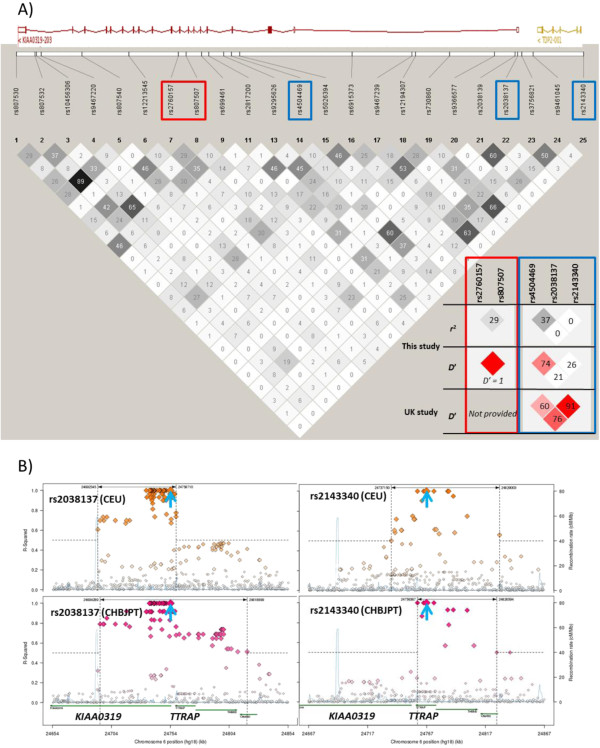
Linkage disequilibrium plots of SNPs located in KIAA0319.(A) Inter-SNP linkage disequilibrium was generated for studied markers covering KIAA0319 using Haploview 4.0 [13]. Color scheme represents the r2 value (stronger linkage disequilibrium is shown using progressively darker shading). Schematic diagram of KIAA0319 and TDP2 genes obtained from Ensembl (http://www.ensembl.org). Right bottom: Linkage disequilibrium plots of the significant haplotype rs2760157-rs807507 (Red box) found in this study (Hong Kong sample) and the haplotype rs4504469-2038137-2143340 (Blue box) studied in Paracchini et al. (UK sample) [16]. Linkage disequilibrium plot represent D’ measure was also generated. The cells are color in red gradually representing strength of LD between the two markers: Bright red (LOD ≥ 2 D’ = 1), pink red (LOD ≥ 2 D’ < 1) and white color for no or weak LD (LOD < 2, D’ < 1). (B) Regional LD plots in KIAA0319 5′ and TTRAP (TDP2) genomic region (plots were generated using SNAP web-based software at the Broad Institute [17] and data from 1000 Genomes Project Pilot 1). r2 value relative to rs2038137 and rs2143340 (indicated by blue arrows) in CEU and CHBJPT populations for SNP in a 100Kb window around it plotted against their genomic location. Dotted vertical lines delimit regions including SNPs with r2 > 0.5. Size and color intensity of markers are proportional to r2 values.